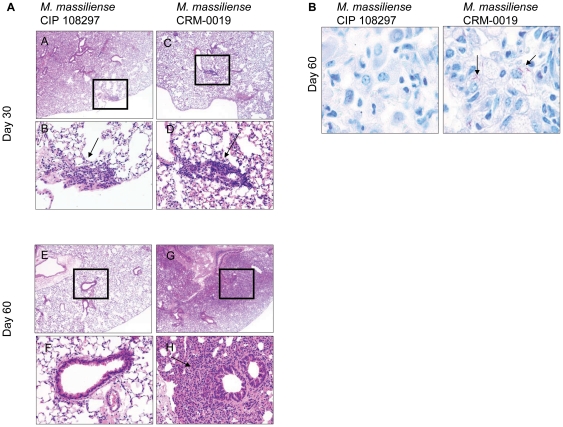
Lung histology from M. massiliense infected IFNγ-KO mice.Panel A, A-H shows representative lung histopathology from the M. massiliense CIP 108297- and epidemic CRM-0019-infected animals on day 30 and 60 of the infection. Tissue sections are stained with hematoxylin and eosin. The lower photograph depicts the magnified region denoted by the square (upper photograph). CRM-0019-infected mice (panel A: D and H) showed an increased rate of granuloma (arrows) progression and involvement of larger areas of the lung compared to the control mice (panel A: B and E). Panel B shows representative lung acid fast staining bacilli at day 60 after M. massiliense CIP 108297 and CRM-0019 infection. Total magnification, panel A [A, C, E, G]  =  10x; panel A [B, D, F, H]  =  20x; panel B  =  100x.